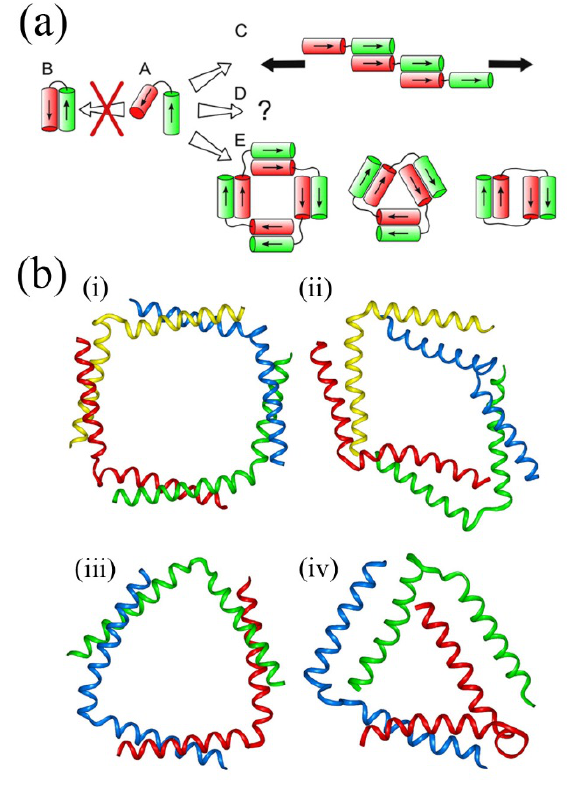
Figure 8. De Novo design in peptide self-assembly. ( a ) Proposed assemblies based on inter-helix assembly in helix-linker-helix molecules. Two linked coiled-coil peptides (A) were designed such that antiparallel assembly (B) is not favoured. Fibrous structures (C) and closed structures (E) are favoured depending on the linker (black line, disordered peptide sequence) length. Black arrows for C indicate that fiber propagation can occur at either end; ( b ) (i)–(iv) Molecular dynamics simulations of two peptide self-assemblies. (i) and (iii) show the starting positions ( i.e. , T = 0 ns)of the model structures of two different helix-linker-helix molecules with their respective structures after 100 ns shown in (ii) and (iv). Adapted from ref. [68]. Copyright (2012) American Chemical